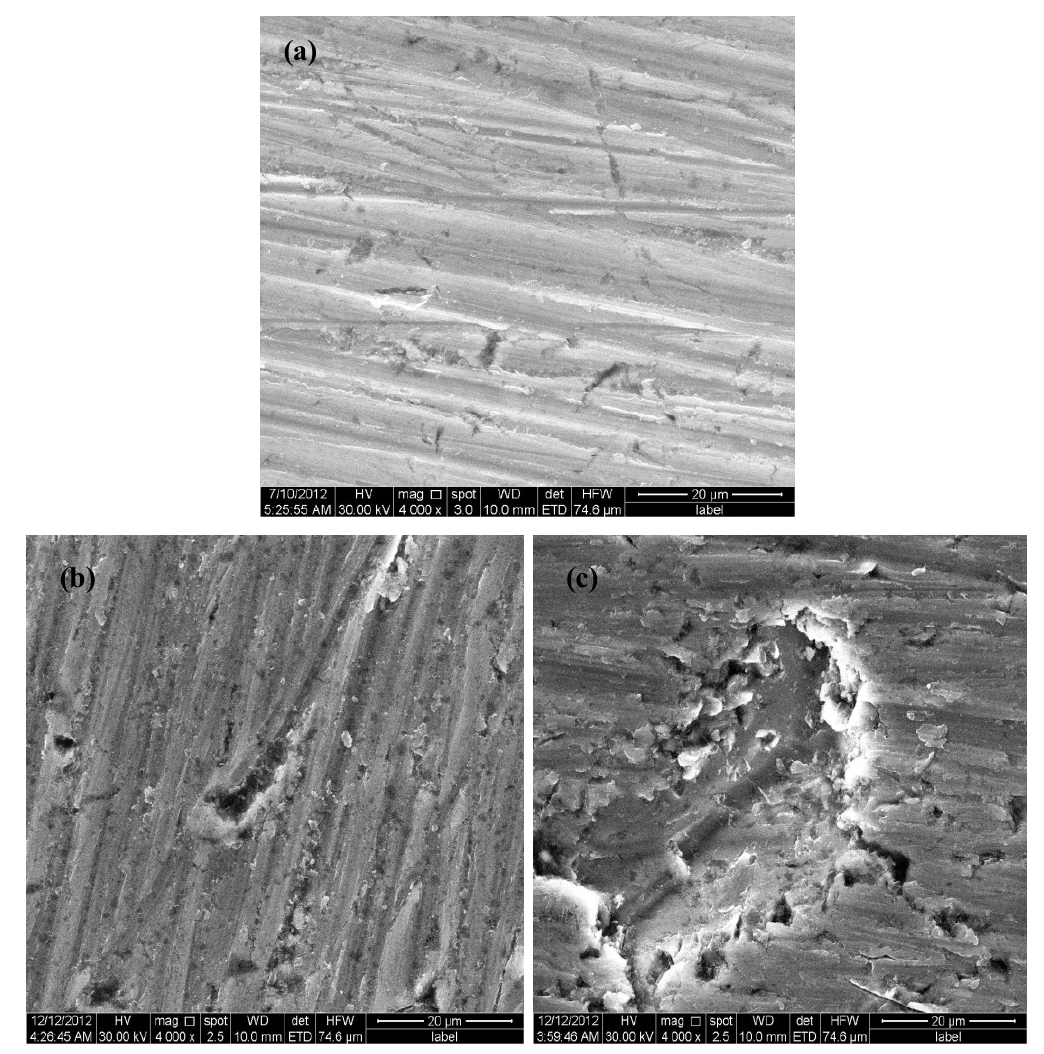
Figure 8. Surface morphologies of titanium immersed in artificial saliva: ( a ) in the absence of lactic acid; and ( b ) in the presence of 3.2 g/L; and ( c ) 5.0 g/L lactic acid for 14